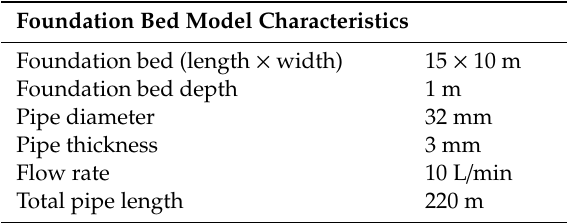
Table 4. Foundation bed dimensional model characteristics.